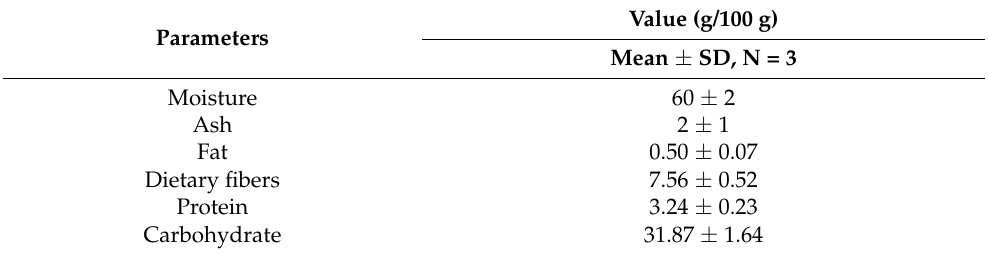
Table 1. Chemical composition of the extracted taro mucilage.